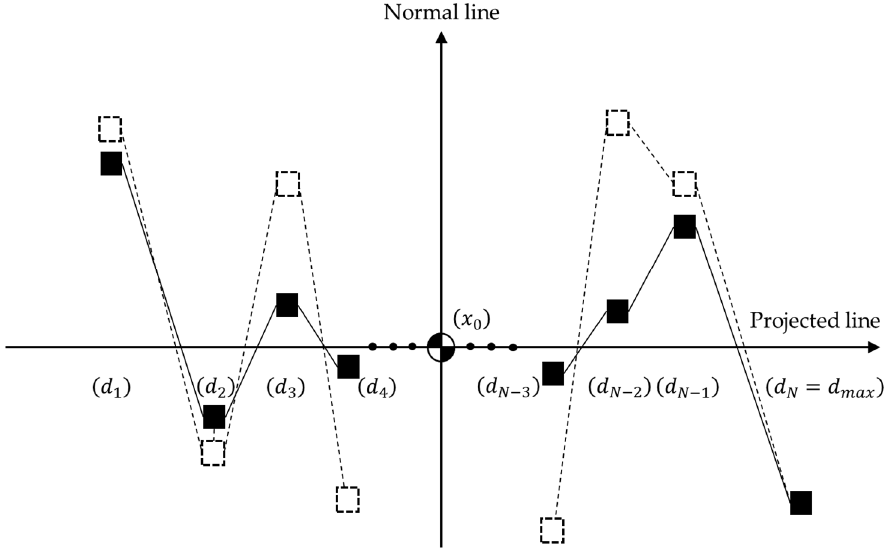
Figure 3. Original and amplified mode shapes of the UCBC structure; modified.